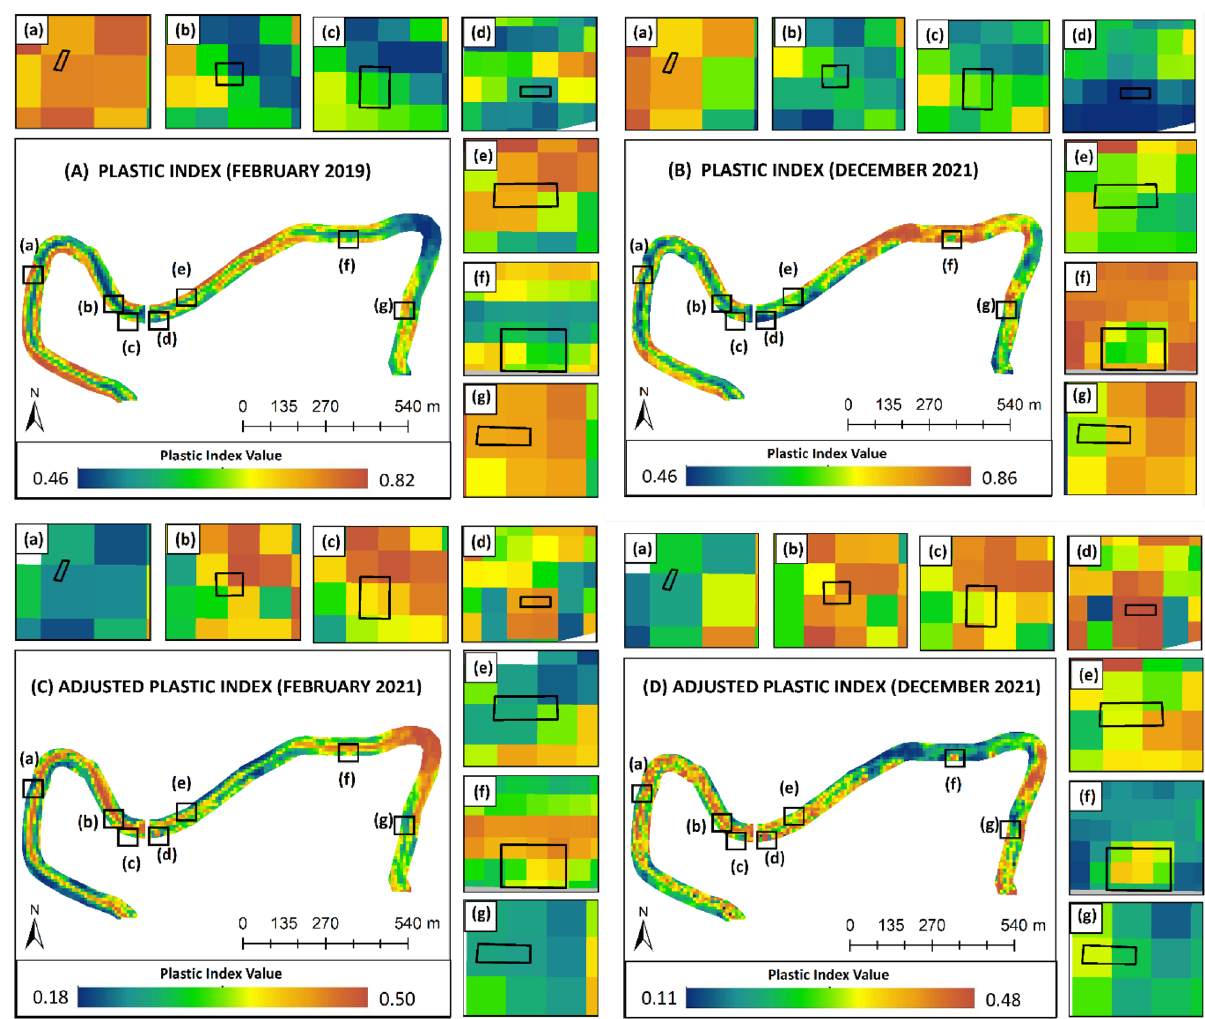
Figure 5. Result of: (A) PI in February 2019, (B) PI in December 2021, (C) API in February 2019, and (D) API in December 2021.